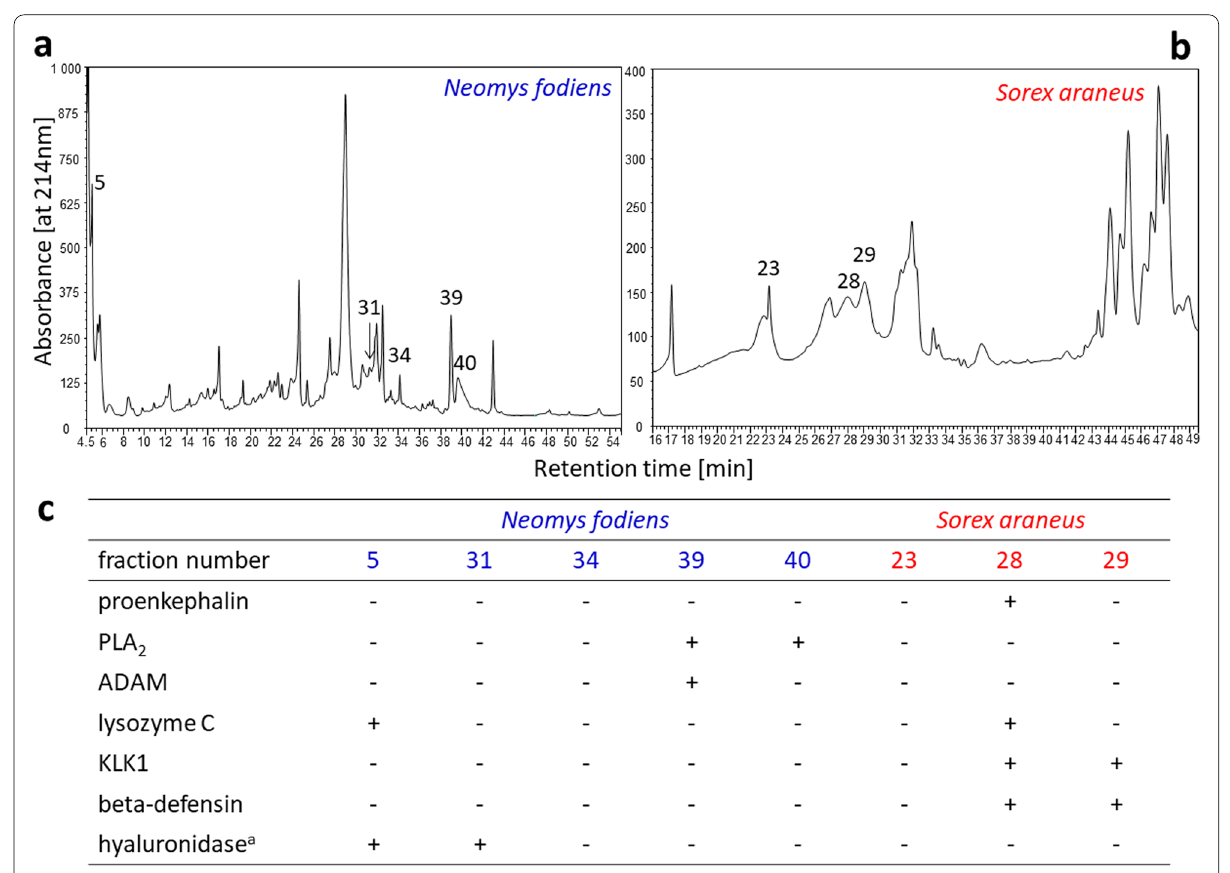
Fig. 3 Chromatographic separation of the extract from venom glands of Neomys fodiens ( a ) and Sorex araneus ( b ). Numbers indicate the fractions selected to identify toxins. ( c ) Toxins identified in the selected fractions (see Additional files 1 and 2 in the Supplementary information section for the complete list of proteins identified in the extracts from venom glands of both shrew species). Abbreviations: ADAM, a disintegrin and metalloproteinase domain-containing protein; KLK1, kallikrein 1-related peptidase; PLA 2 , phospholipase A 2 . ( indicates the absence of toxin in the given